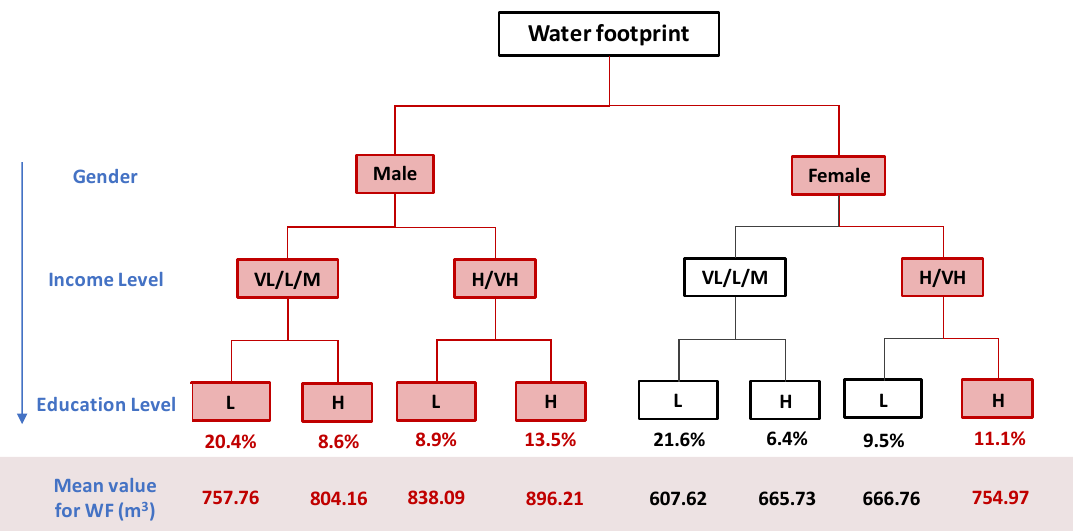
Figure 5. A decision tree for judgment of the water footprint consumption tendency where the red color indicates a high consumption tendency. The percentage number under the decision tree represents the percentage of the number of samples under the category to the total number of samples. The real number indicates the average water footprint of 8 groups of people (m 3 per year) . For income level, VL, L and M mean very low, low and middle income level respectively, while H and VH mean high and very high income level. For education level, L and H mean low and high education level respectively.